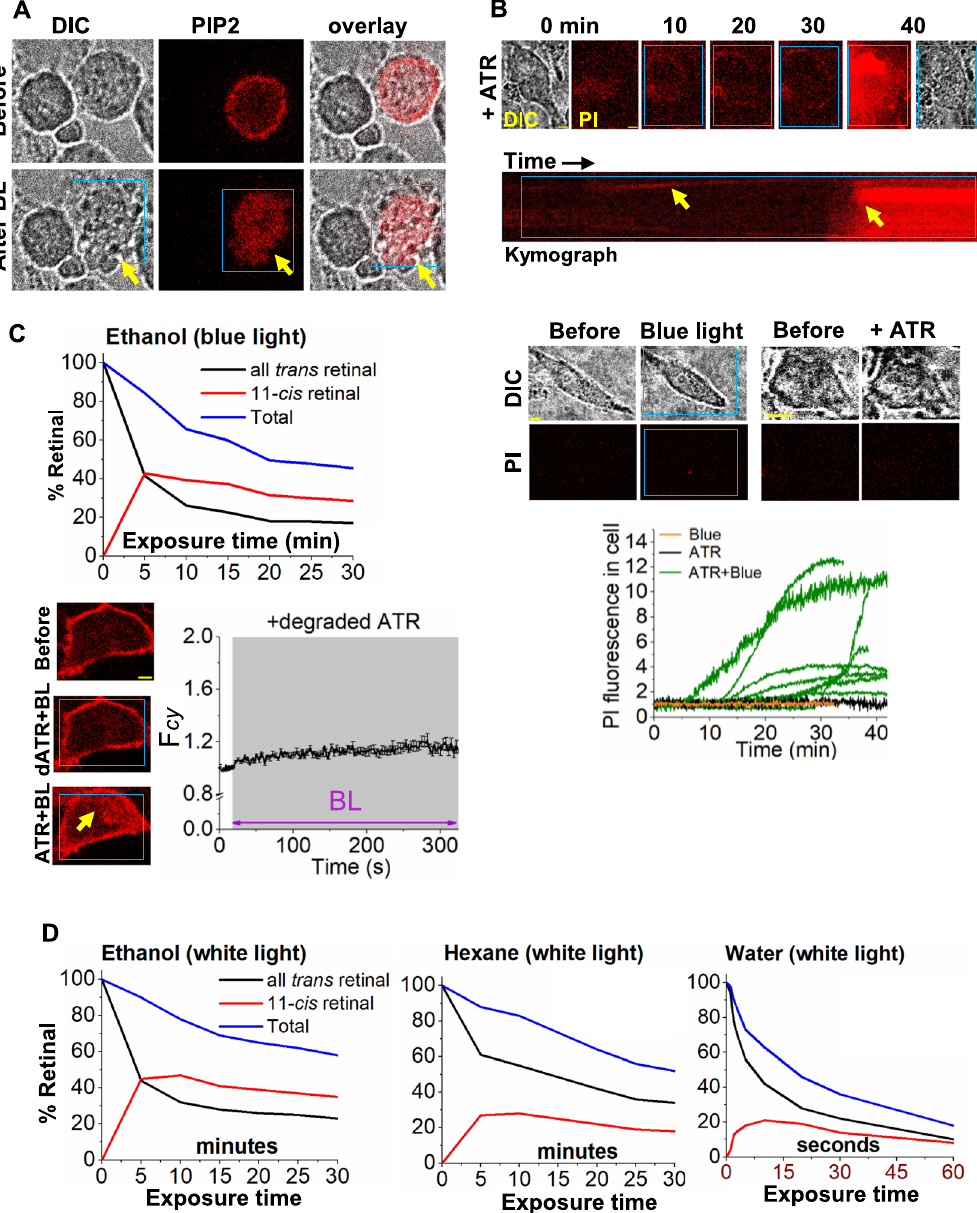
Figure 7. Photoexcited retinal induced cytotoxicity. ( A ) Fluorescence and DIC images of HeLa cells treated with ATR (50 µ M) followed by blue light exposure (4.86 µ W of 445 nm). Only the middle cell (yellow arrow) expresses PIP2 sensor. Blue light exposed (blue box) cell showed substantial change in cell shape and morphology. The PIP2 sensor also accumulates in cytosol upon blue light exposure. ( B ) HeLa cells were incubated with propidium iodide (PI) with ATR (50 µ M) and exposed to blue light (4.86 µ W) for 45 minutes. Incorporation of PI in to cells were observed upon light exposure. The control experiments performed with cells exposed to only to blue light or only to ATR, did not show PI incorporation into cells over time. Plot shows the different rates of PI incorporation into cells compared to control experiments. ( C , D) Solvent dependent degradation and isomerization of ATR. ( C ) ATR (20 µ L of 50 mM in ethanol) was exposed to blue LED light for 30 minutes. The blue light exposed ATR (injection sample: 1 µ L of exposed ATR was diluted in 1 mL of ethanol) was analyzed by HPLC where degradation of ATR is observed by reduction of corresponding ATR peak in chromatogram. right: The degraded ATR (dATR) (1 µ L) was added to HeLa cells (final volume of imaging buffer = 1 mL) expressing PIP2 sensor and continuously exposed to 445 nm light (4.86 µ W). Cells did not show detectable PIP2 translocation upon blue light. Exposure of cells to fresh ATR (50 µ M) and blue light (BL) induced PIP2 distortion (mean ± S.E.M., n = 12). ( D ) HPLC analysis of retinal in different solvents after exposing to white light for varying durations. Note that retinal in water degrades in seconds while in ethanol and hexane show over 100 times enhanced stability. Improved isomerizations were seen as well. Mean and S.E.M. are from 3 < independent experiments. (blue light (BL) = blue box). Scale = 5 µ